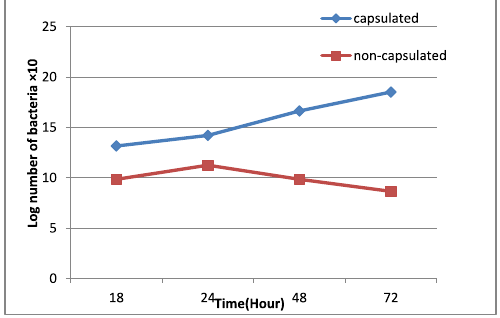
Fig. 2. Viable count of capsulated and non-capsulated K. ozaenae recovered from mice spleen. Each dot acts log10 CFU per gm of spleen (mean) for 3 mice.